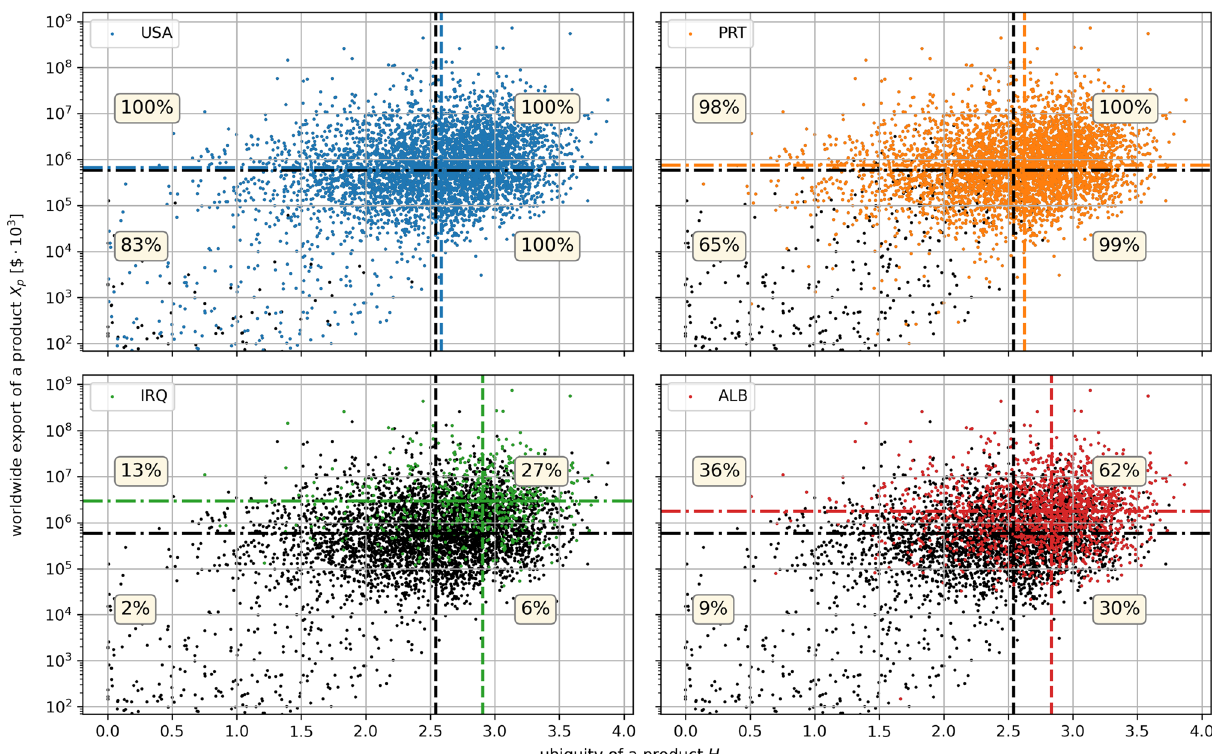
Figure 5. Prouducts exported by USA (top-left), Portugal (top-right), Iraq (bottom-left) and Albania (bottom- right) in the worldwide export vs. ubiquity plane of Fig. 4b. Black dots represent all the existing products, while the colored ones are only those actually exported by each country. It is clear how least developed countries tend to have medians (colored lines) leaning towards more ubiquitous and highly exported products (the black lines are the medians for all the existing